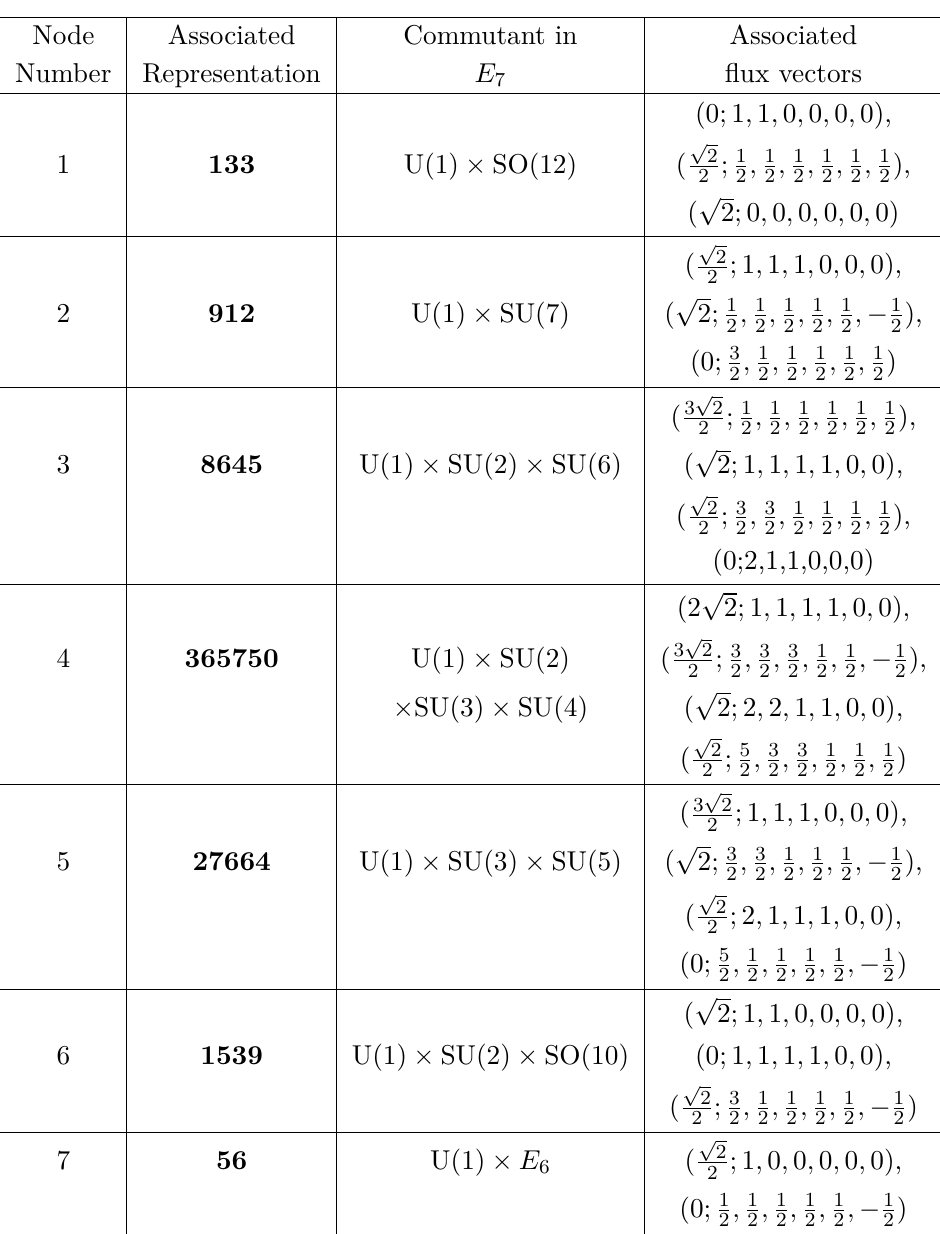
Table 2 . Flux vectors associated with various representations of E 7 and their preserved symmetry.